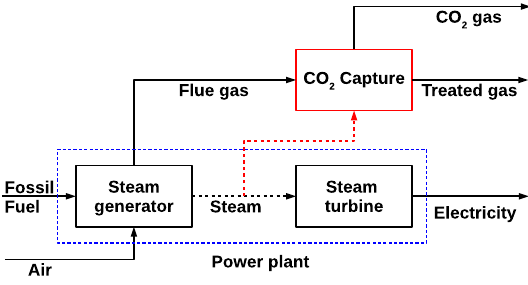
Figure 1. Overview of electricity generation with post-combustion CO 2